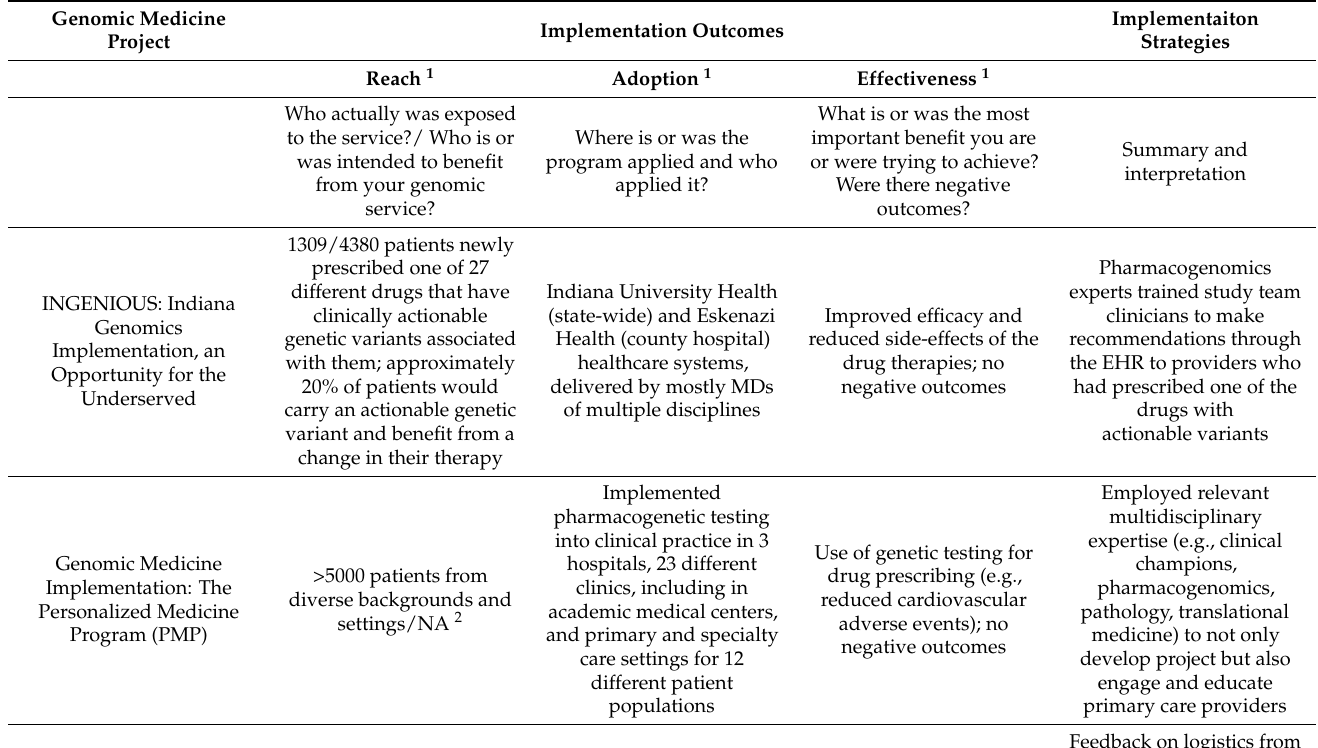
Table 4. Implementation outcomes and strategies of IGNITE 1 genomic medicine